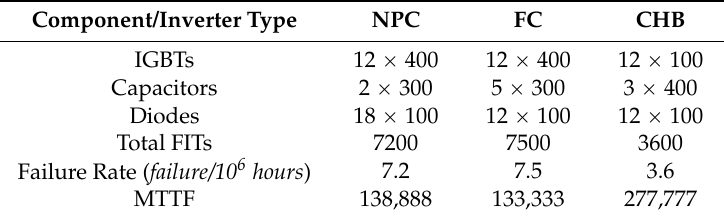
Table 3. The approximate MTTF for three considered